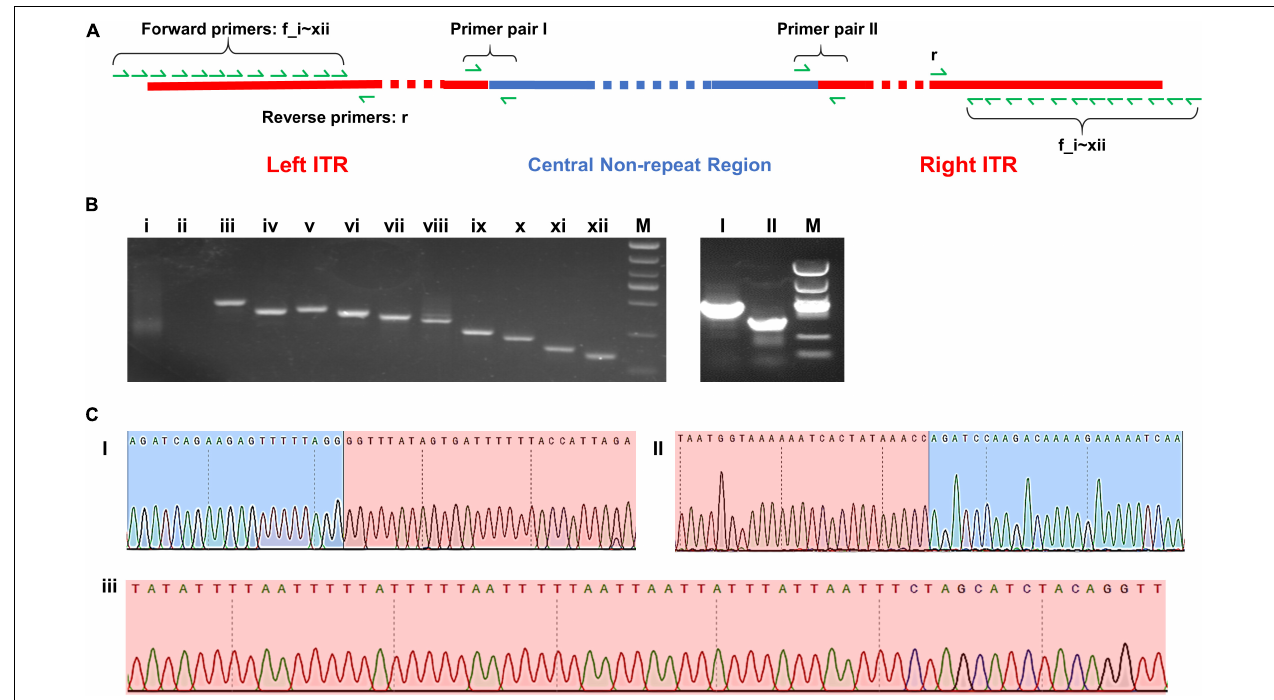
FIGURE 5 | (A) Schematic diagram of the complete map of Me. baoshan genome with the location of PCR primers. (B) Agarose gel electrophoresis analysis of PCR product. Lanes i–xii: PCR products using 12 forward primers closing to the extremities of ITR region pairing with one reserve primers; Lanes I and II: PCR products over the junction of ITR and non-ITR region using primer pairs I and II, respectively. (C) Partial results of Sanger sequencing from lane I, II, and iii. Red background represented ITR region and blue background represented non-ITR